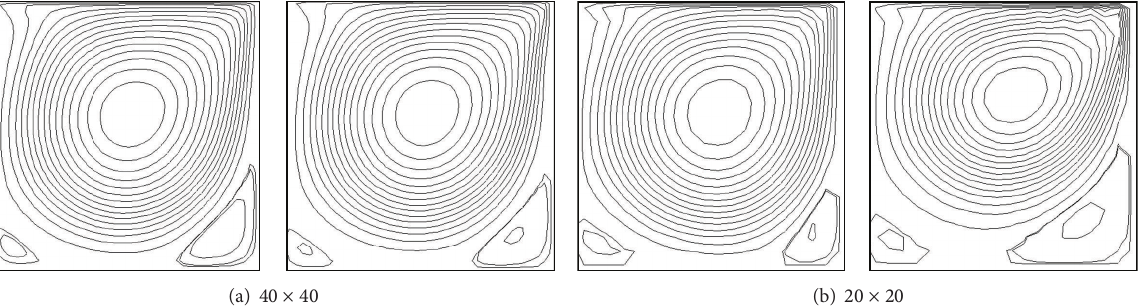
Figure 8: Comparison of stream lines in lid-driven flow with variant mesh densities (FVM in the left column and FDM in the right column).